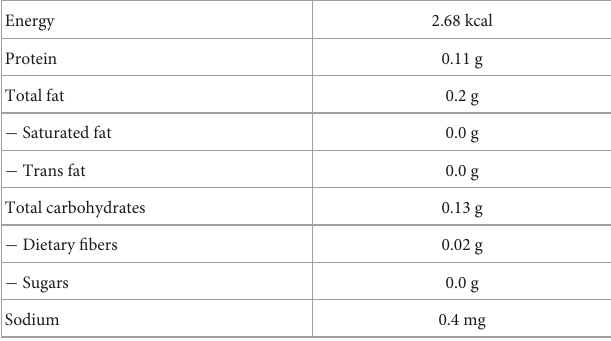
TABLE 1 Nutritional information per serving size of 1 capsule (460 mg) of the oral supplement used in the study. Energy Protein